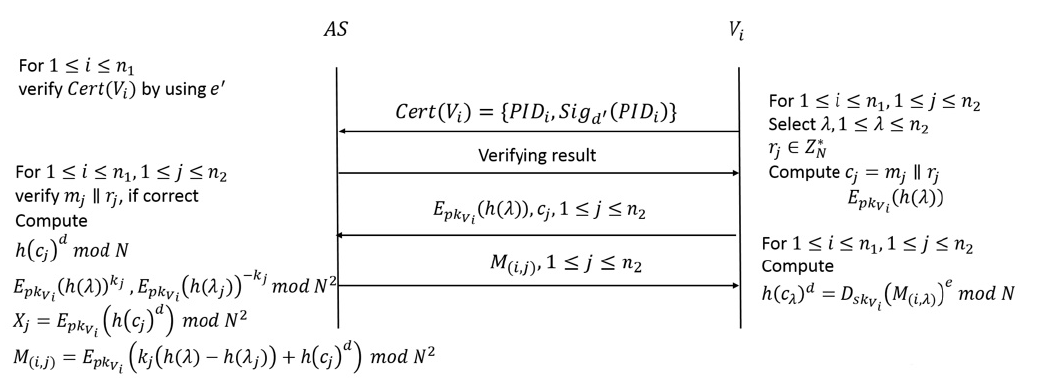
Figure 3. Ballot signature obtained with one-out-of-noblivious transfer